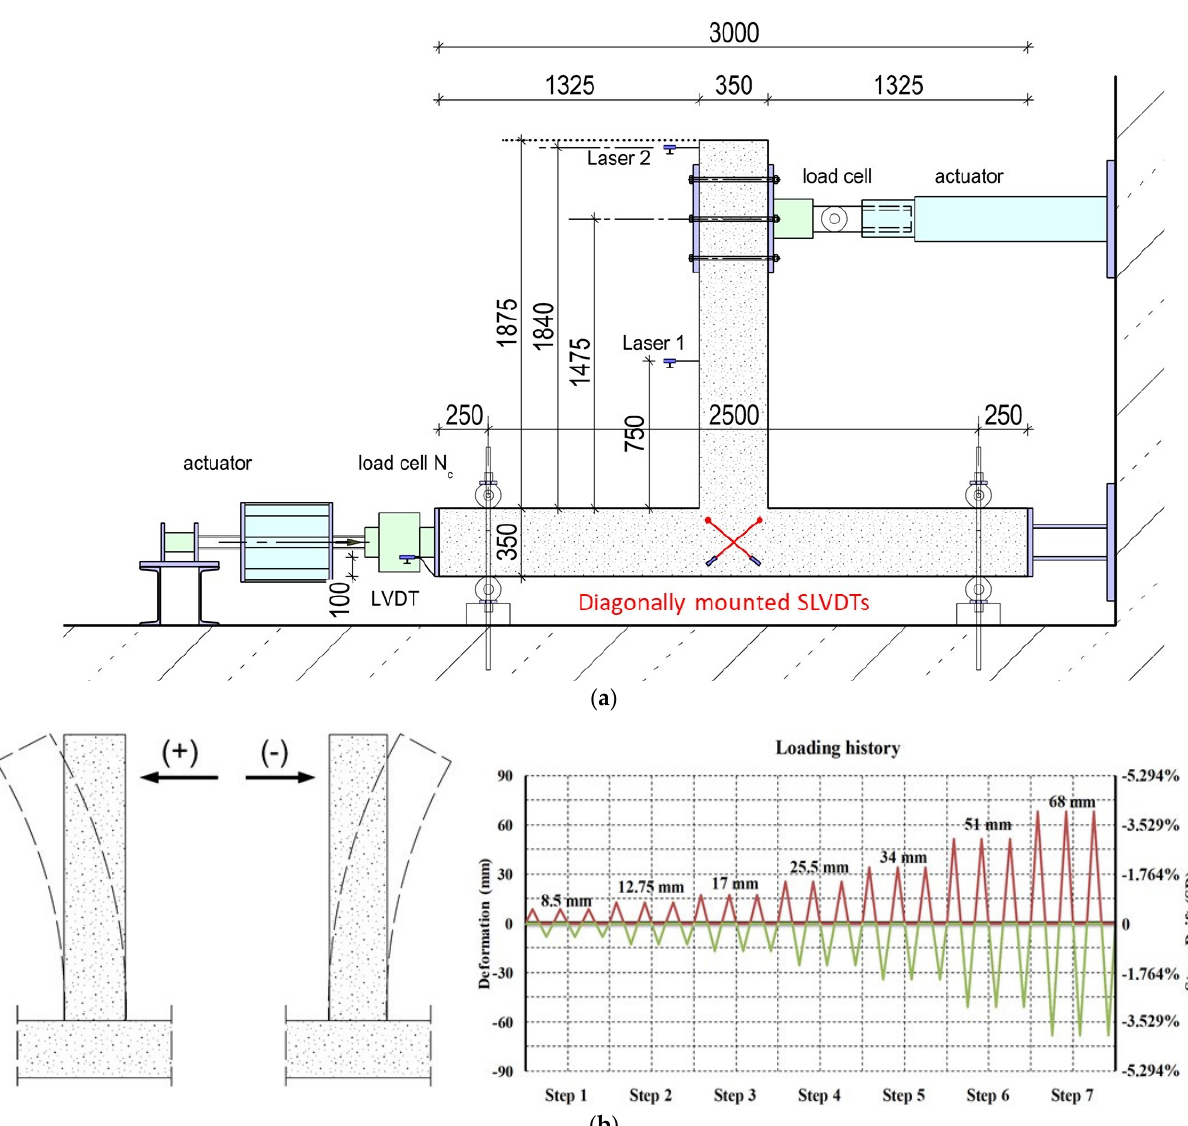
Figure 3. Experimental setup and loading history: ( a ) The column of the BCJ specimen was placed in the horizontal direction and the beam in the vertical direction. The deformation was horizontally imposed near the free end of the beam (dimensions in mm); ( b ) The load sequence included 7 steps and each step comprised three equal full loading cycles.